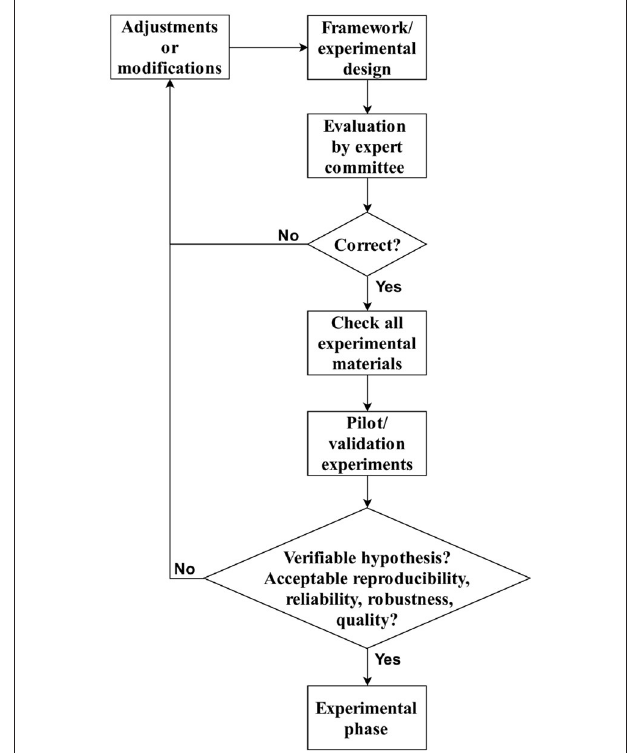
TABLE 4 | Stage of framework validation.